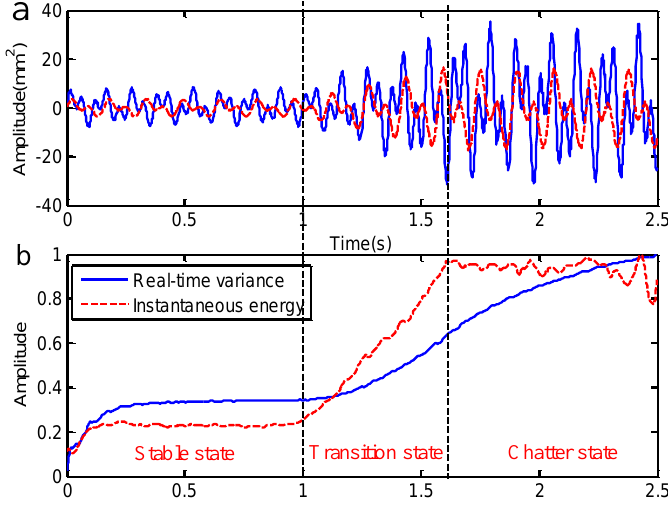
Figure 9. ( a ) The simulated chatter signal; ( b ) superposed and normalized real-time variance and instantaneous energy.